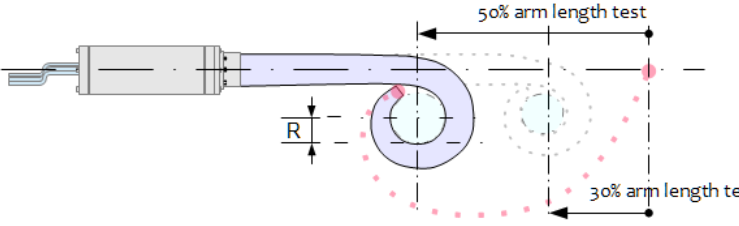
Figure 10. Minimum grasping radius definition diagram.